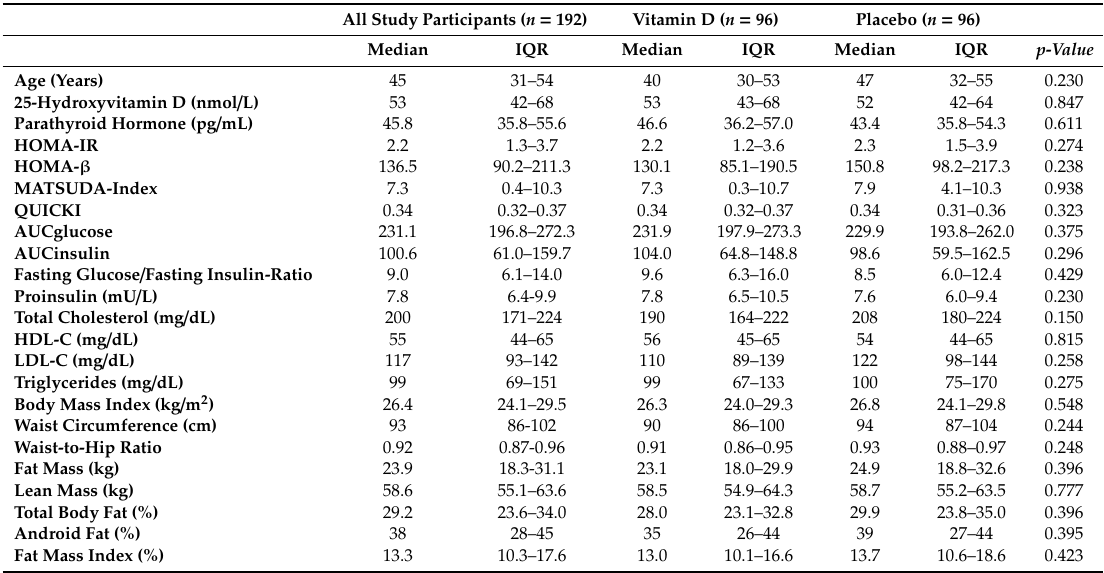
Table 1. Baseline characteristics of study participants. Comparisons of baseline characteristics between men in the vitamin D and the placebo group were performed using student’s